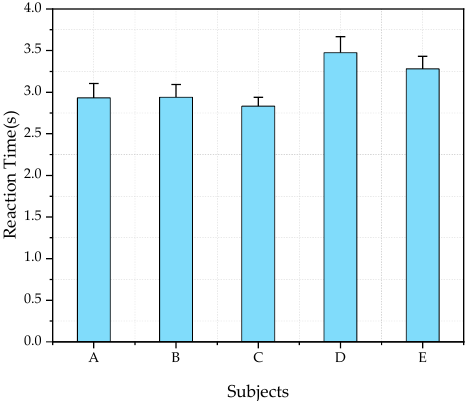
Figure 10. Ten repetitions reaction time of five subjects. CRI2012 = 85, LP-CCT = 2800 K. Error bars indicate the standard deviation.